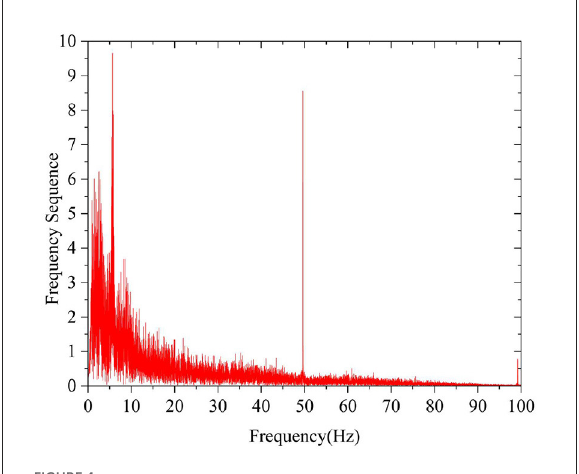
FIGURE4 Spectrogram after bandpass filtering.